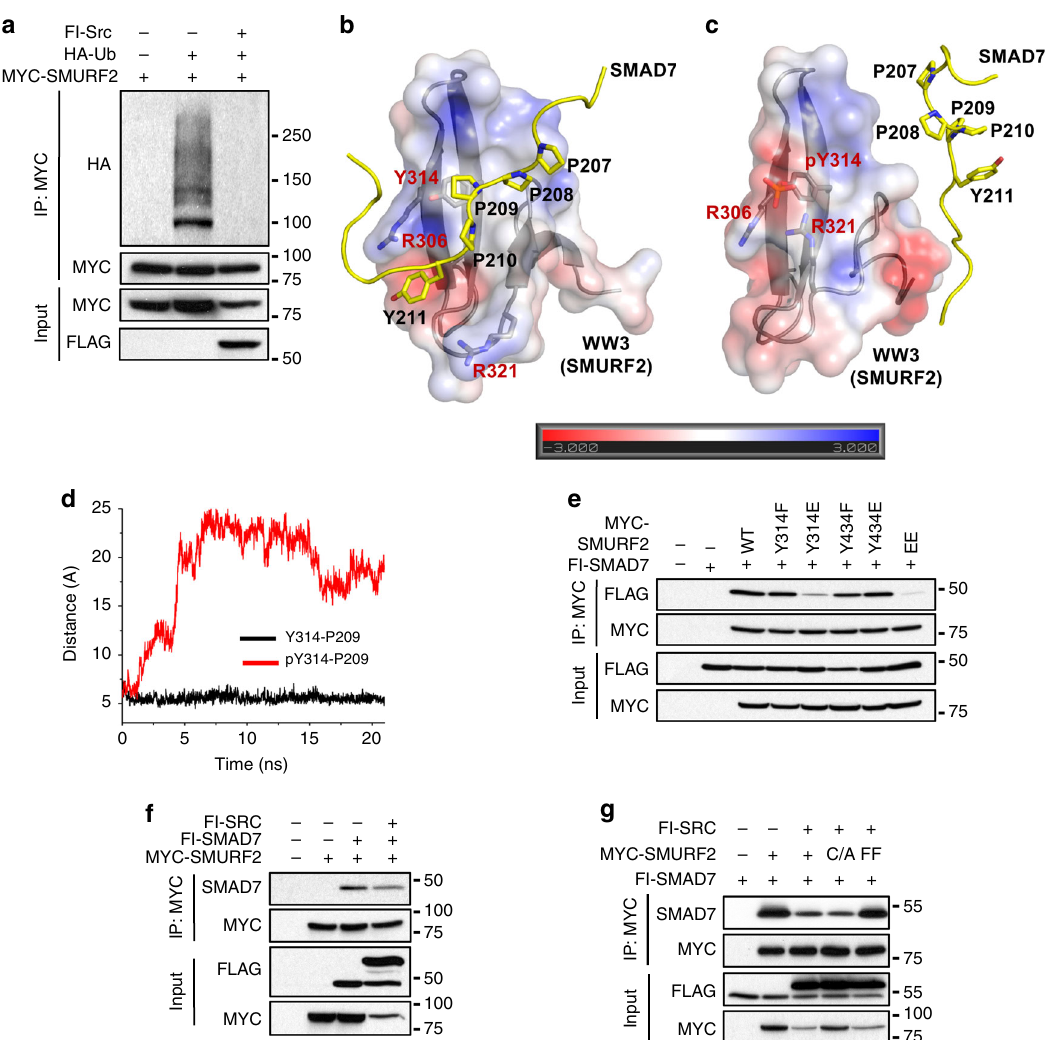
Fig. 4 c-SRC phosphorylation of SMURF2 inhibits SMAD7 binding. a 293 T cells transfected with MYC-SMURF2, Flag-SRC, control vector and HA-tagged ubiquitin. Following immunoprecipitation of MYC-SMURF2 lysates were resolved by SDS – PAGE and probed with indicated antibodies. b , c Representative structure from MD simulation of WW3 domain of SMURF2 in complex with a peptide from SMAD7 in b unphosphorylated state of Y314 and c phosphorylated state of Y314. The WW3 domain is shown in electrostatic surface and ribbon representation, whereas the SMAD7 peptide is shown in yellow colour in ribbon. The PY motif of SMAD7 and Y314 along with the adjacent arginine residues of WW3 domain is shown in stick representation. d Time series plot (in angstrom unit) of the centre of mass distance between Y314 of WW3 domain and P209 from SMAD7 peptide in the phosphorylated (red colour) and unphosphorylated (black) states of Y314 during the MD simulation of WW3-SMAD7 complex. e 293 T cells were transfected as indicated with MYC-tagged SMURF2 or corresponding mutants and FLAG-tagged SMAD7. After 48 h, cells were lysed and immunoprecipitated with anti-MYC af fi nity resin. Whole-cell extracts were probed with the indicated antibodies. f 293 T cells were transfected as indicated with MYC-tagged SMURF2, Flag- tagged SMAD7 and/or Flag-tagged c-SRC. After 48 h, cells were lysed and immunoprecipitated with anti-MYC af fi nity resin. Whole-cell extracts were probed with the indicated antibodies. g 293 T cells were transfected as indicated with MYC-tagged SMURF2, MYC-tagged SMURF2(C/A) or MYC-tagged SMURF2(FF), Flag-tagged SMAD7 and/or Flag-tagged c-SRC. After 48 h, cells were lysed and immunoprecipitated with anti-MYC af fi nity resin. Whole-cell extracts were probed with the indicated